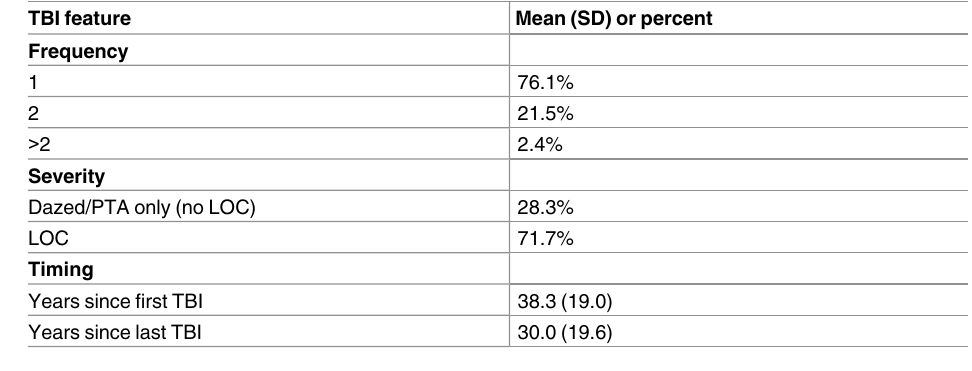
Table 2. Traumatic brain injury